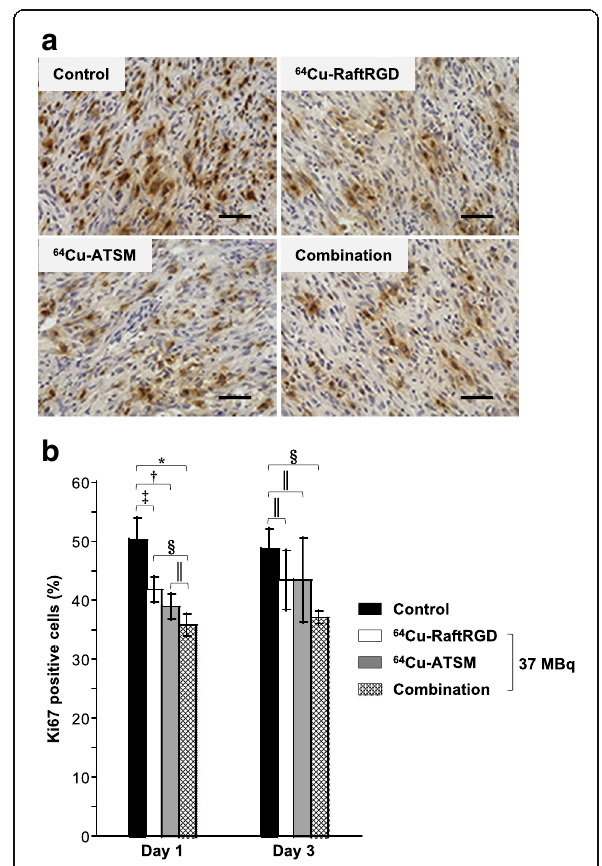
Fig. 4 Ki67 staining (dark brown) of the tumor sections at days 1 and 3 p.i. of the vehicle solution (control) or 37 MBq of 64 Cu-RaftRGD, 64 Cu-ATSM, or a combination (18.5 MBq for each agent). a Representative images at day 1. Scale bar, 50 μ m. Nuclei were lightly stained with hematoxylin (blue). b Quantitative analysis of Ki67 staining (the percentage of positively stained cells). n =3 − 4/group; * , † , ‡ , § P < 0.0001, 0.001, 0.01, and 0.05, respectively; ║ P